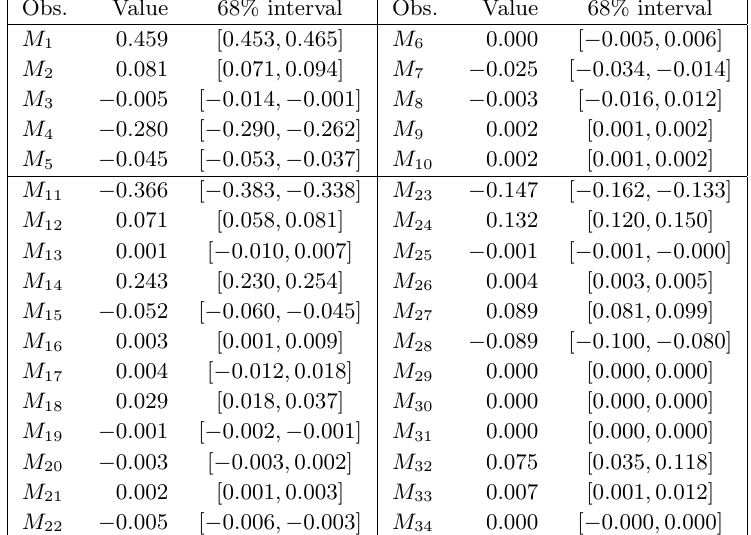
Table 2 . Predictions from EOS for the angular observables of the (cid:3) in the range 1 < q 2 < 6 GeV 2 =c 4 . The SM calculation is described in the text. The observables M 31 and M 34 vanish due to the small size of the muon mass. Observables that depend on the imaginary part of the product of two transversity amplitudes also tend to be vanishingly small, due to the small strong phase di(cid:11)erence between pairs of amplitudes in the SM.